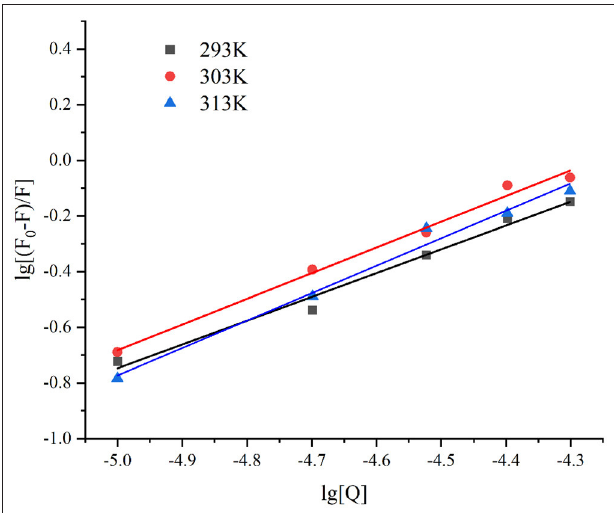
FIGURE 4 | The linear plot of lg [( F 0 - F )/ F ] against lg [Q] at different temperatures, T = 293, 303, and 313K.